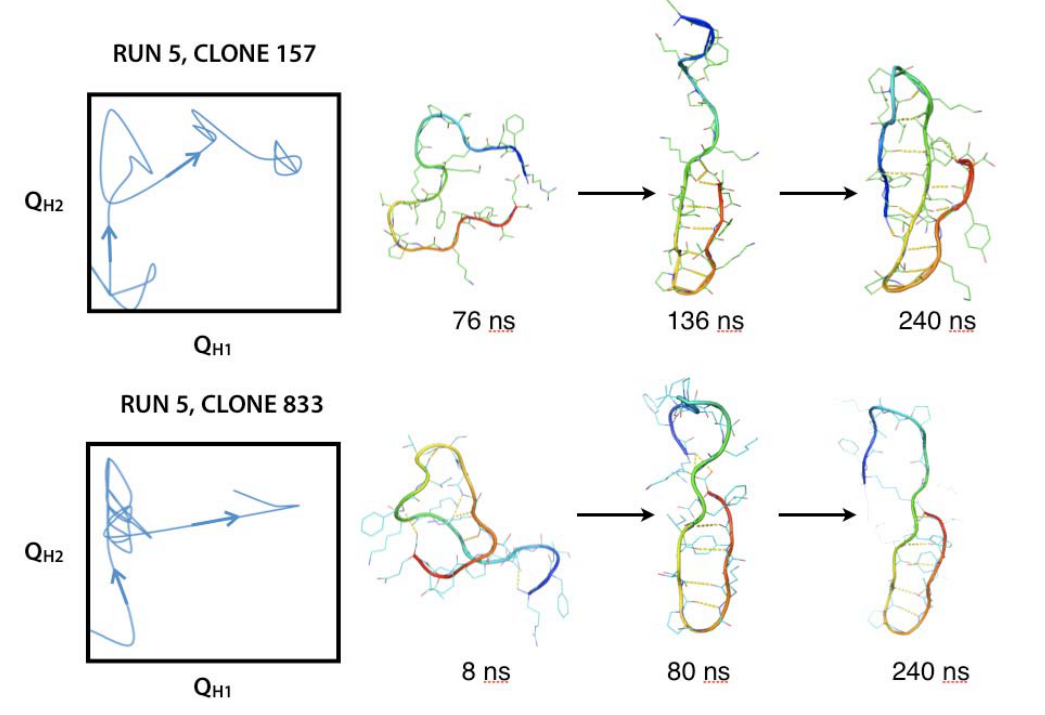
Figure 9. Only two of 10,000 AMBER96 trajectories show folding events for D P D P-II within 240 ns. Shown is the time course of reaction coordinates Q monitor the fraction of hairpin 1 and hairpin 2, with conformational snapshots. The second of the two trajectories is “native” by our reaction-coordinate definition, although hairpin 1 does not have a fully hydrogen-bonded